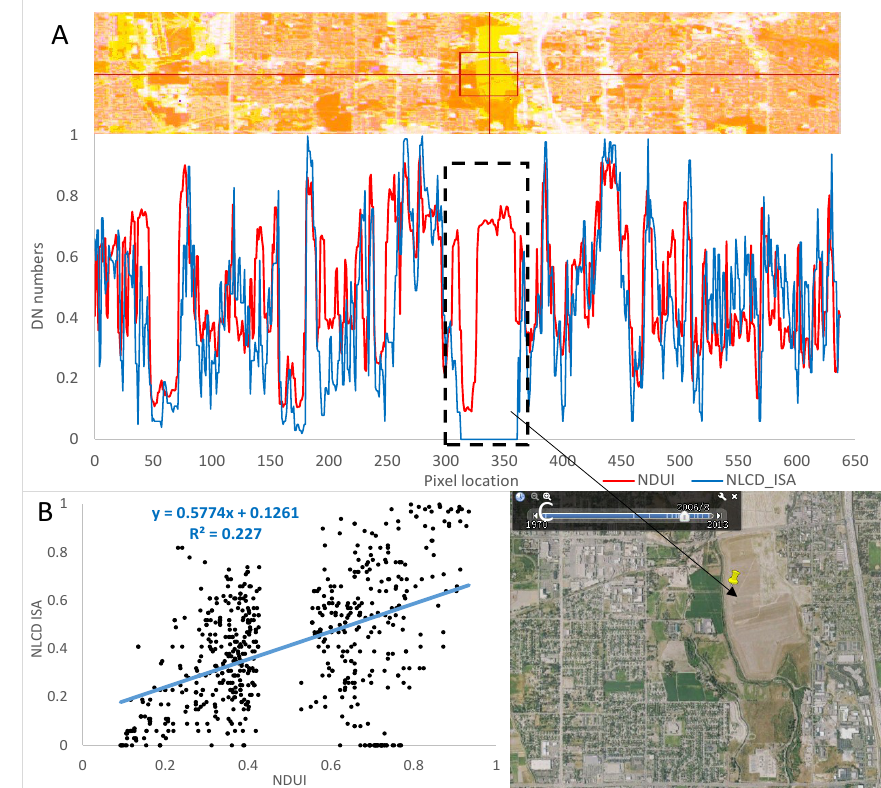
Figure 12. The latitudinal profiles of NDUI and NLCD ISA in Salt Lake City ( A ), and the linear regression model between them ( B ). Panel ( C ) shows a Google Earth snapshot, which reveals that the piece of land within the dotted rectangle was bare in 2006. The upper graph of panel A is a false color composite (Red: NDUI, Green: NDUI, Blue: NLCD